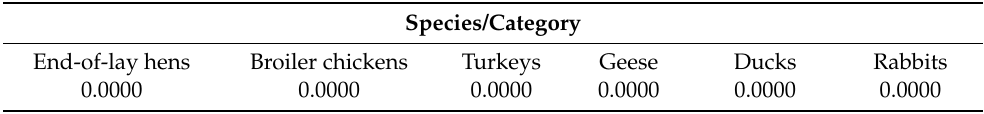
Table 4. The pairwise comparisons ( p -value) of frequency of traumatic injuries to limbs and trunk in monitored animal species and